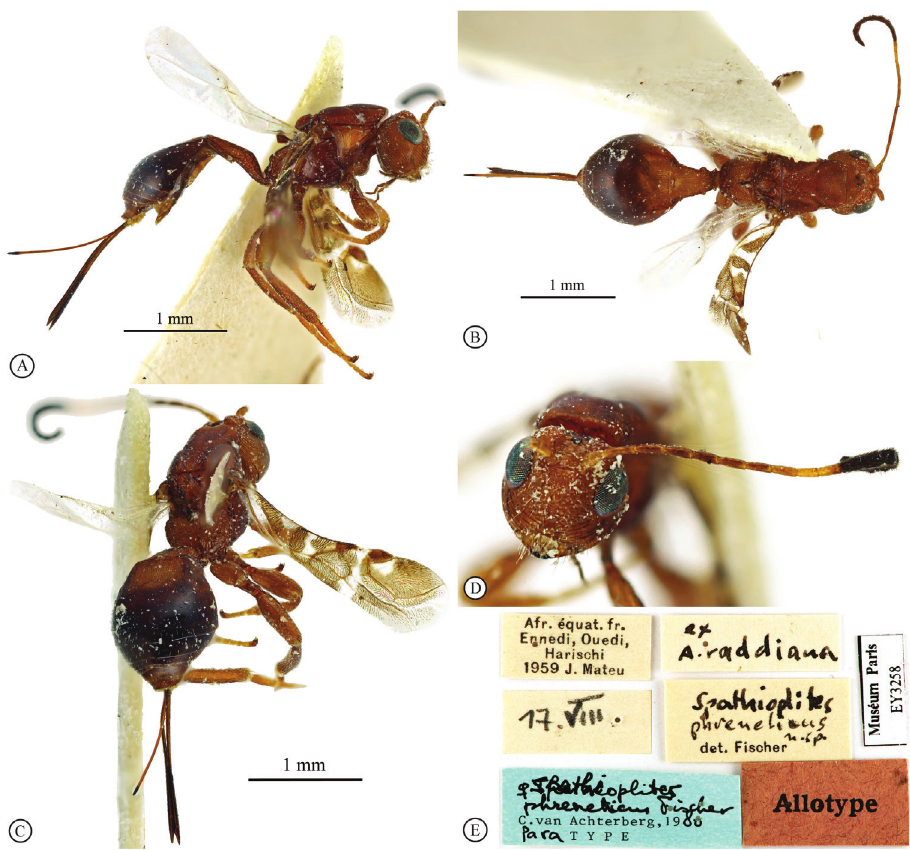
Figure 5. Spathioplites phreneticus , female paratype (MNHN) A habitus, lateral view B habitus, dorsal view C habitus, dorso-posterior view D head, antenna, anterior view E data